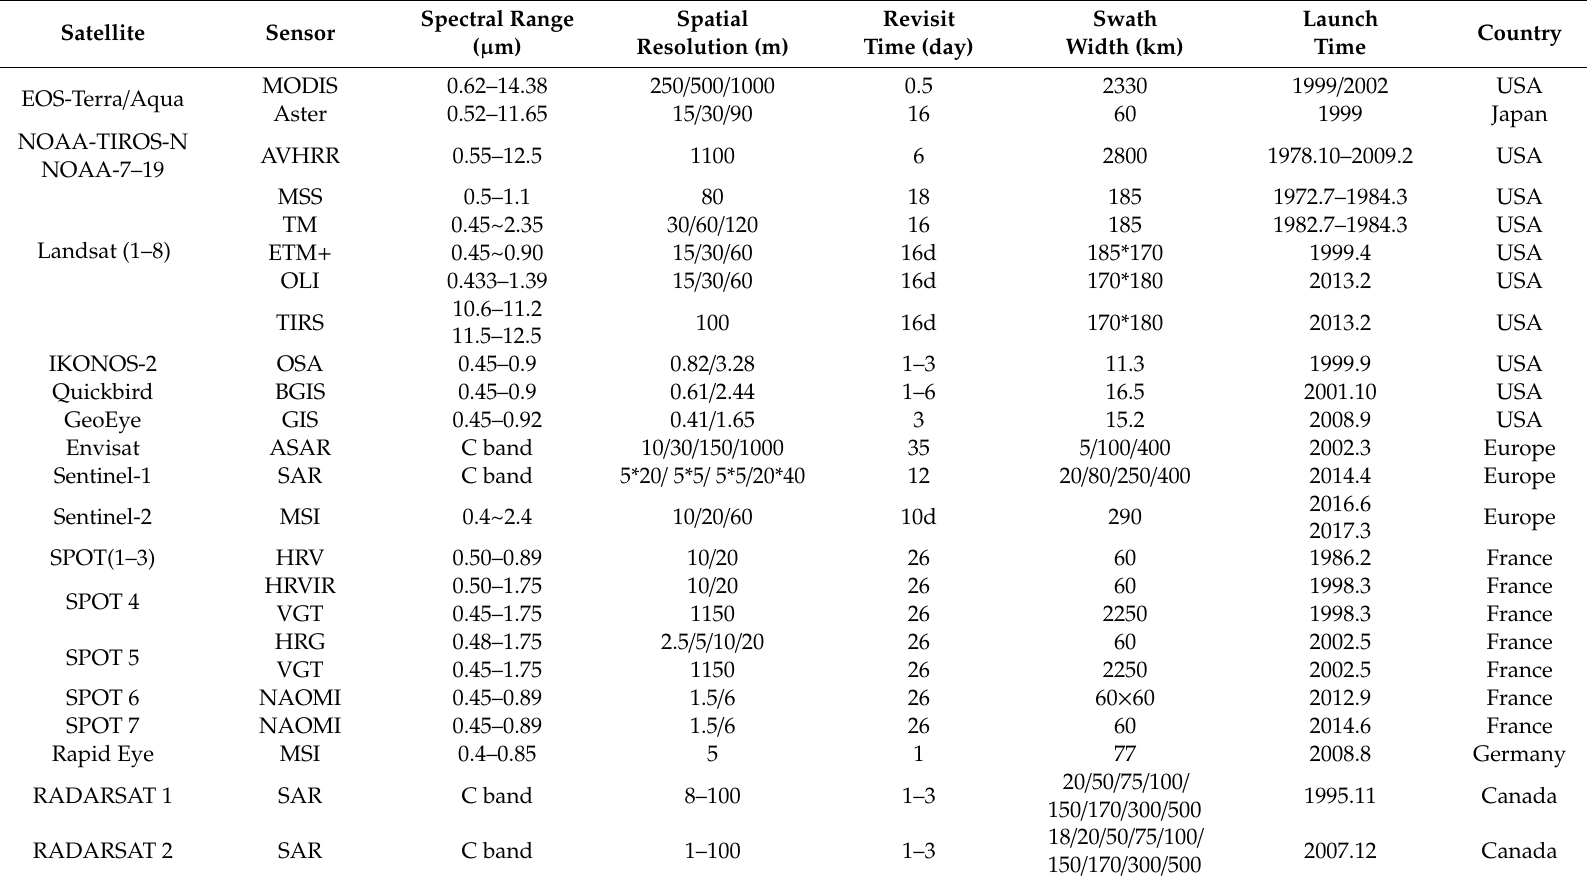
Table 1. Major satellite sensors used for environmental monitoring in